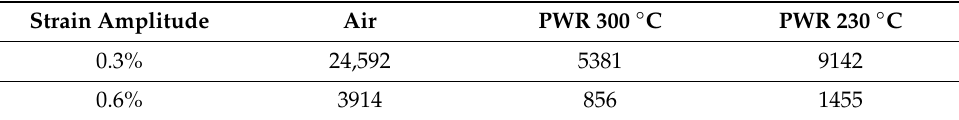
Table 4. NUREG / CR6909-estimated N 25 fatigue life.